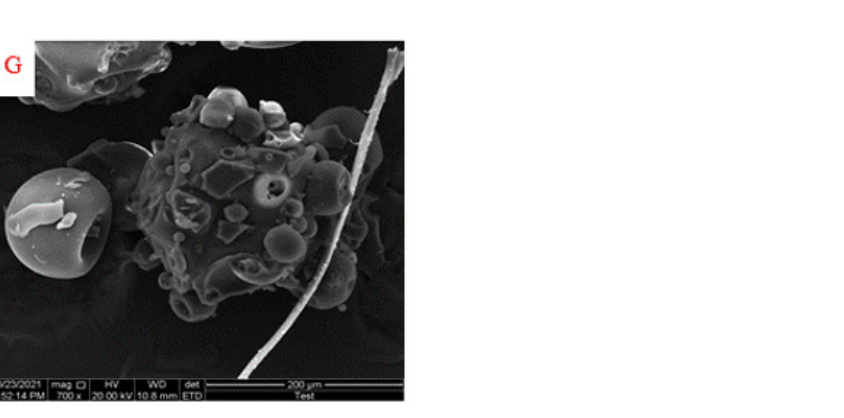
Figure 2. The morphology of microcapsules prepared by different ratios of GA:WPI (( A ) GA:WPI = 1:9; ( B ) GA:WPI = 3:7; ( C ) GA:WPI = 5:5; ( D ) GA:WPI = 7:3; ( E ) GA:WPI = 9:1; ( F ) GA; ( G ) WPI).